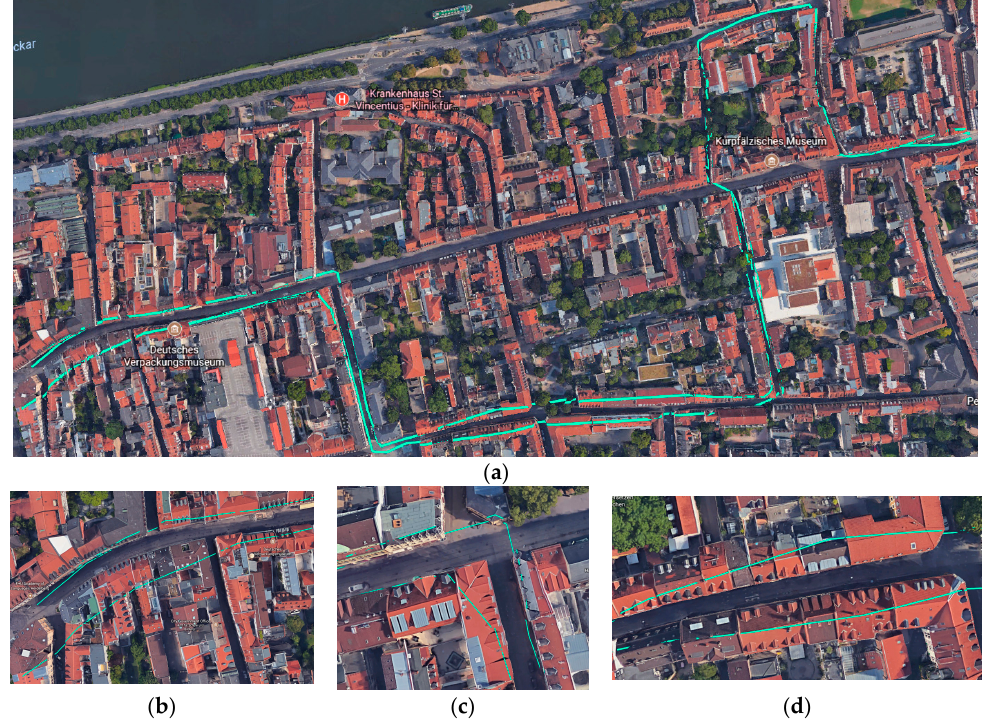
Figure 10. Results of visual inspection of sidewalk network with Google Maps (before applying the enhancement stage): ( a ) the overlaid sidewalk network for the whole experiment area; and ( b – d ) examples of positional inaccuracies.